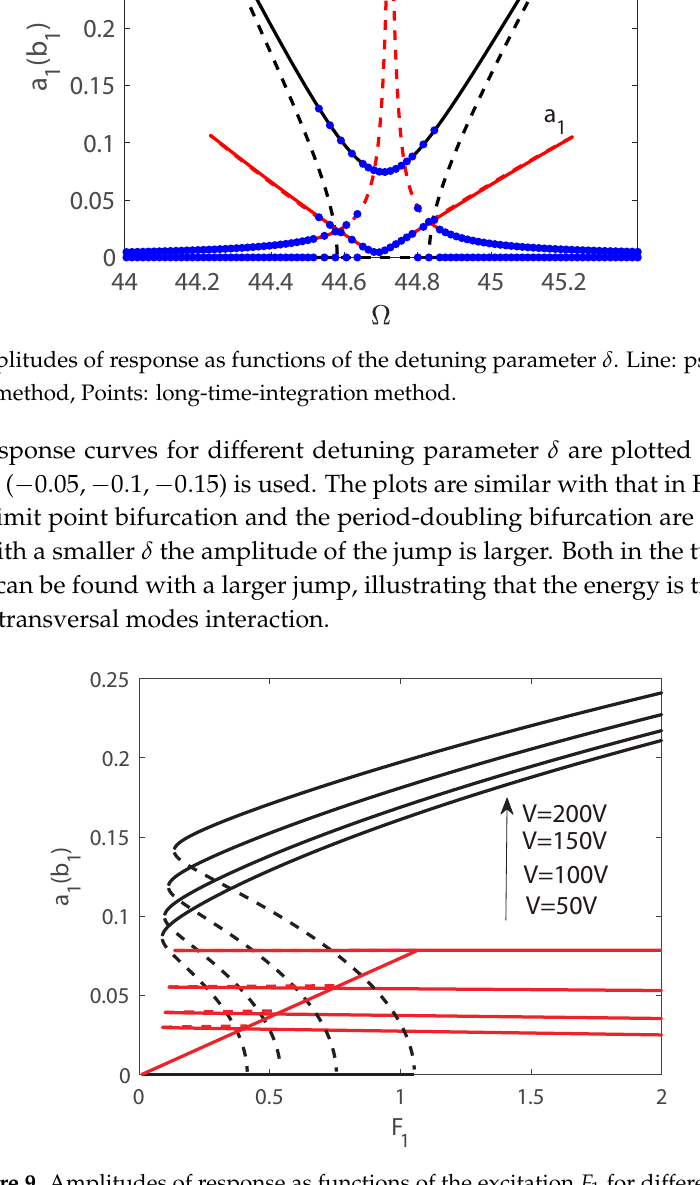
Figure 9. Amplitudes of response as functions of the excitation F 1 for different V dc